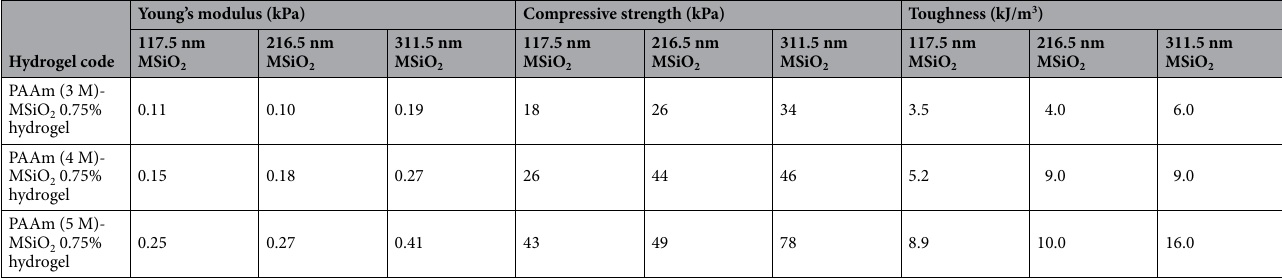
Table 4. Summary of compressive properties of PAAm-MSiO 2 hydrogels prepared by varying the concentration of AAm (3 M, 4 M, and 5 M) and keeping the constant concentration (0.75 wt%) of MSiO 2 particles having different diameters (117.5 nm, 216.5 nm, and 311.5